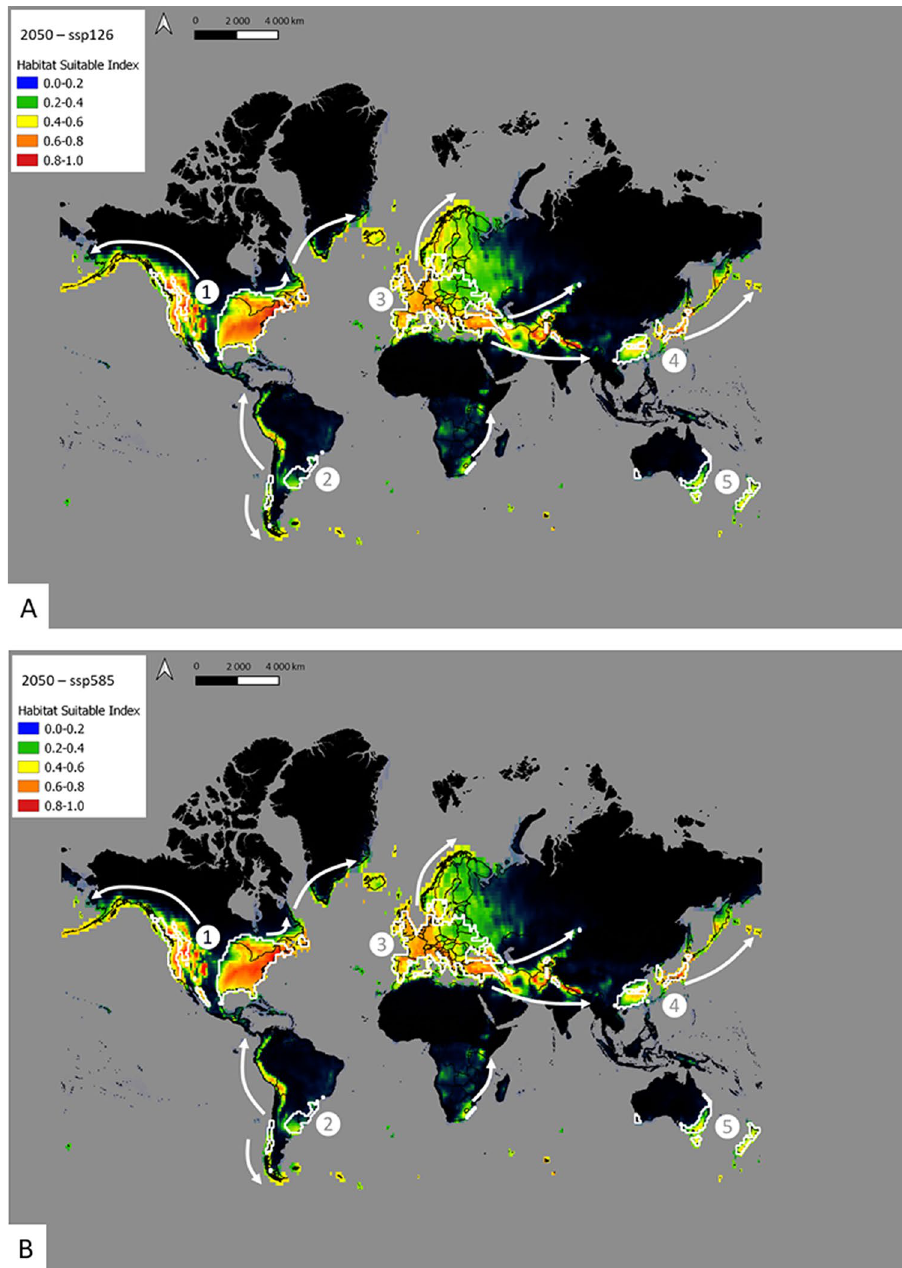
Figure 3. Distribution of Craspedacusta sowerbii under future climate conditions in 2050 in ( A ) lower limit (SSP126) scenario and ( B ) upper limit (SSP585) scenario. White arrows show the expansion of C. sowerbii from the main hotspots (indicated by numbers) observed in the current predictions (white areas). Map produced using QGIS version 3.16.3 software, https:// www. qgis. org/ fr/ site/ index.